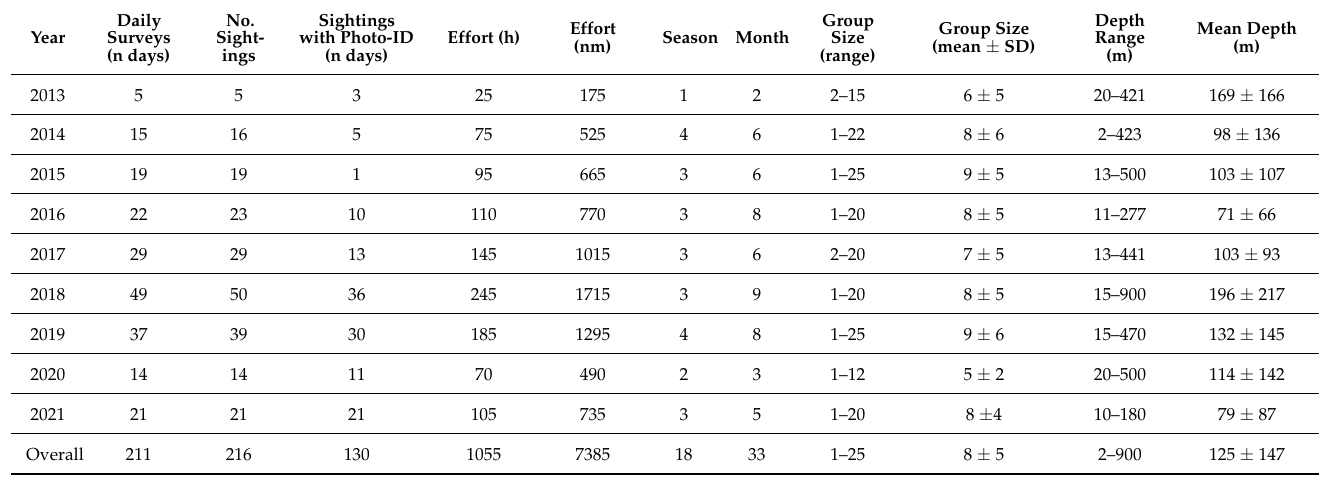
Table 1. Number of daily surveys, seasons and months sampled with indication of effort (in hours and nm), group size (range and mean values) and depth values (range and mean values) recorded during the sightings of bottlenose dolphins in the Gulf of Taranto.